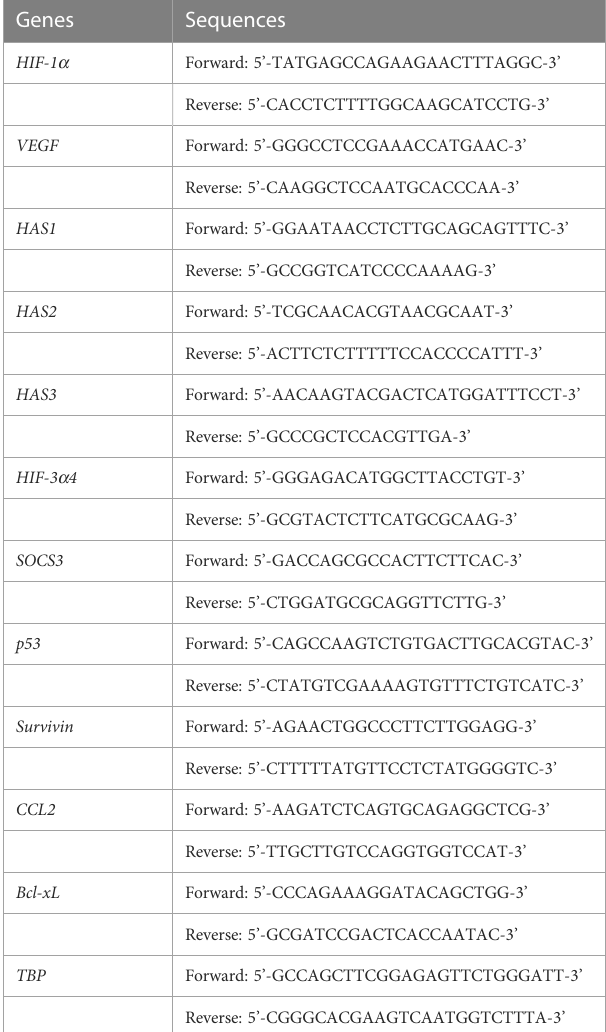
TABLE 1 Primer sequences for real-time